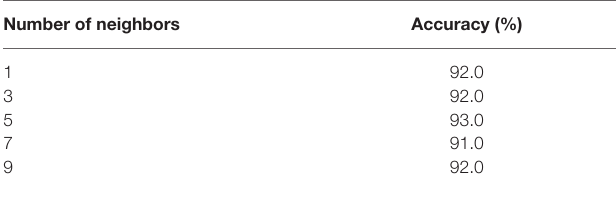
TABLE 2 | Accuracy of the deep learning-based prediction